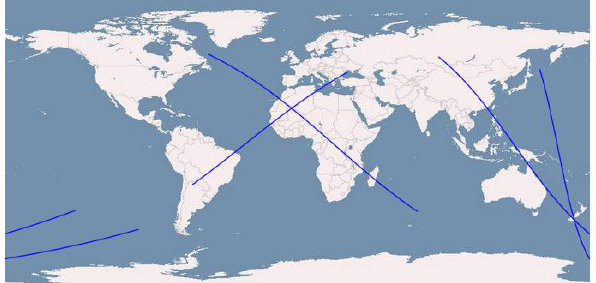
Figure 5. Examples loxodromes in the map section of the visualizer.